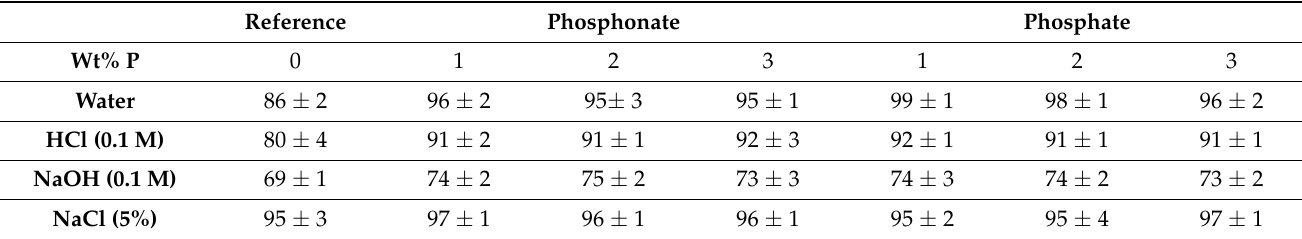
Table 7. Evaluation of chemical resistance of PO x CR-alkyd